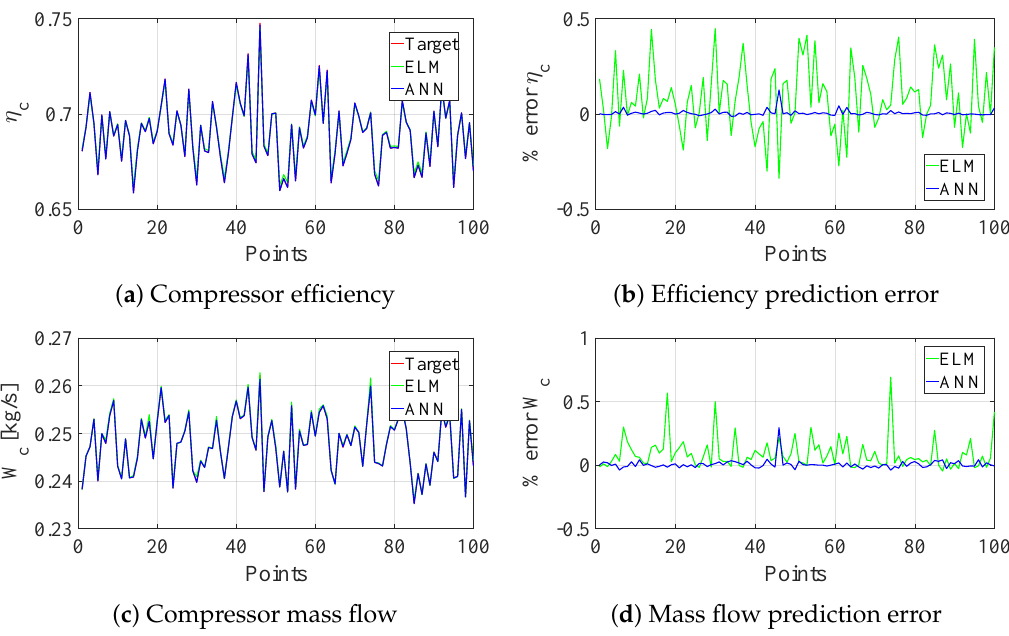
Figure 10. Compressor degradation in flight regime 2 with input vector 1: comparison between the target and prediction of the component performance parameters.